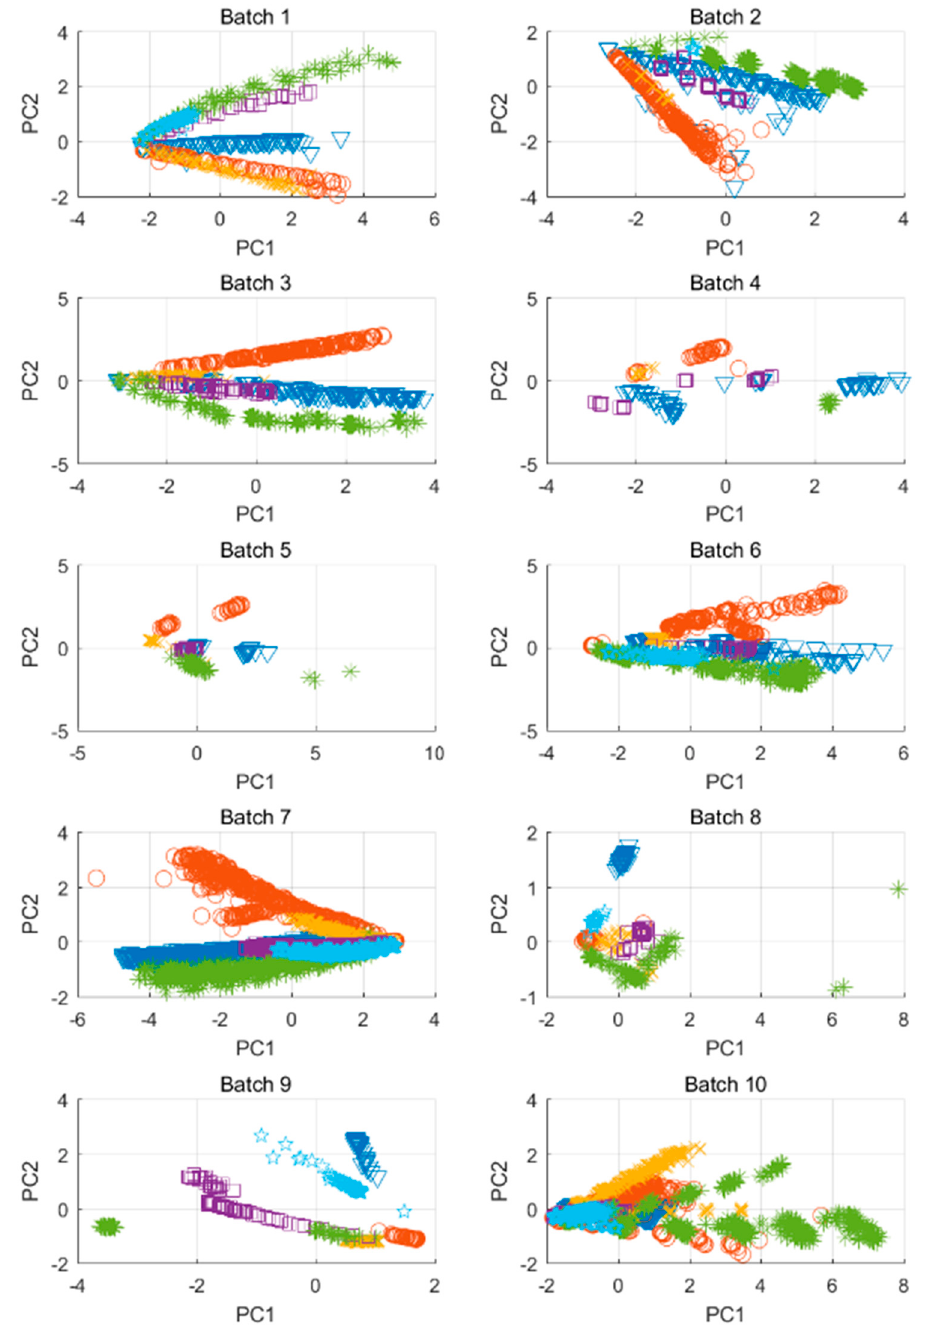
Figure 7. Gas sensor drift dataset from [36]. Each color represents a different gas. Each panel represents a measurement “batch” at various times spanning 36 months. Reproduced from [36] without modification, under Creative Commons Attribution 4.0 License.